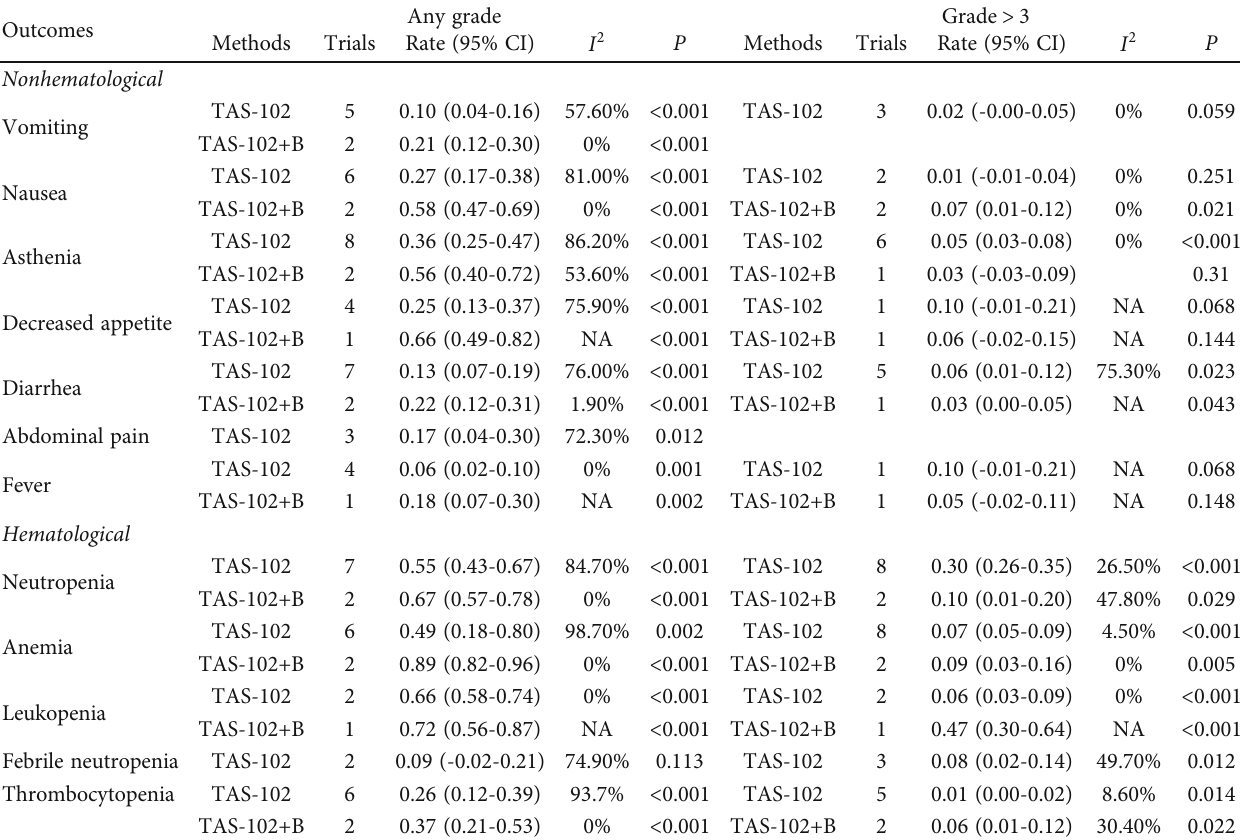
Table 4: Meta-analysis results for the occurrence of adverse events in uncontrolled